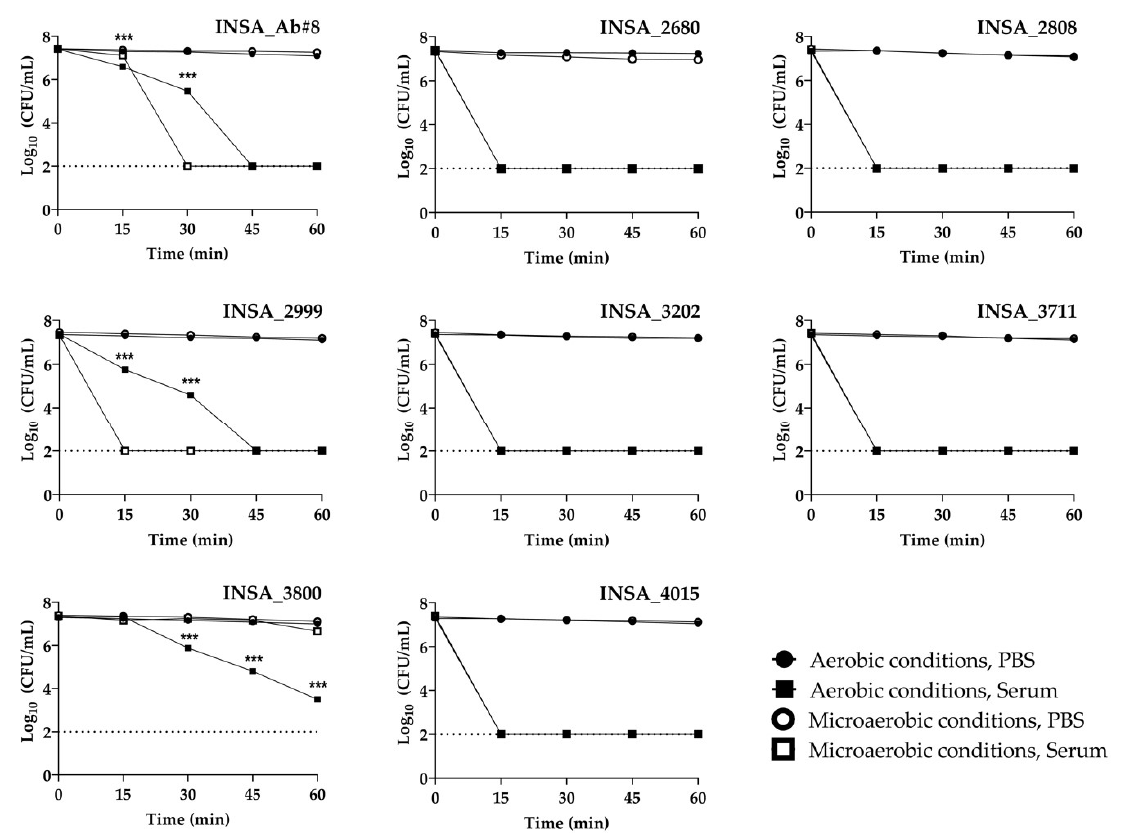
Figure 3. Survival of eight clinical isolates of Arcobacter butzleri to human serum when grown in aerobic or microaerobic conditions. The dashed line represents the detection limit of the assay. Results were analysed between atmospheric conditions when exposed to serum using Student’s t -test The data shown represent the mean ± standard deviation of at least three independent assays. *** p < 0.001.